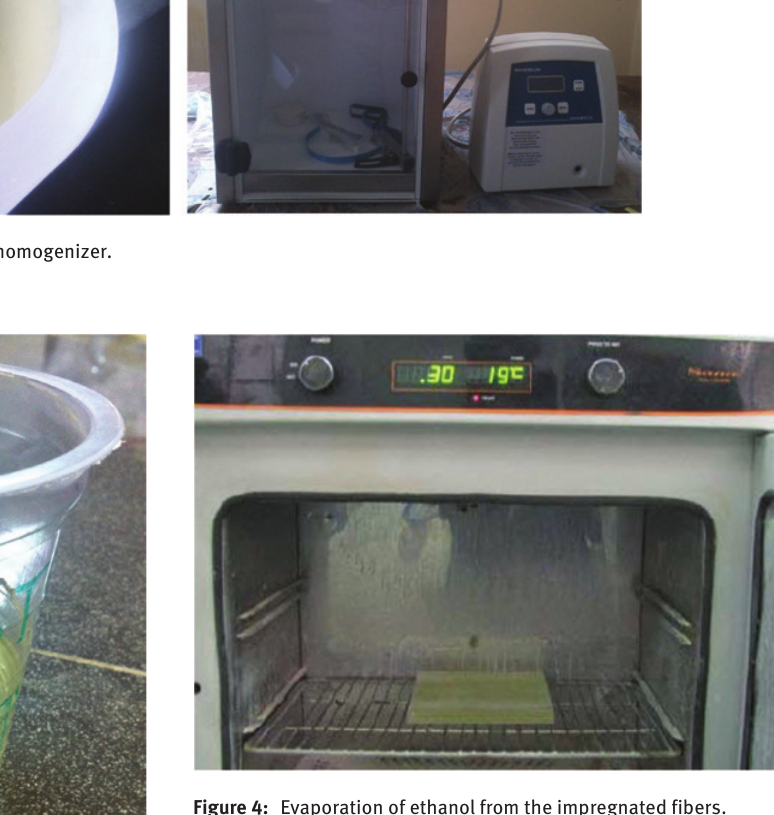
Figure 4: Evaporation of ethanol from the impregnated fibers.